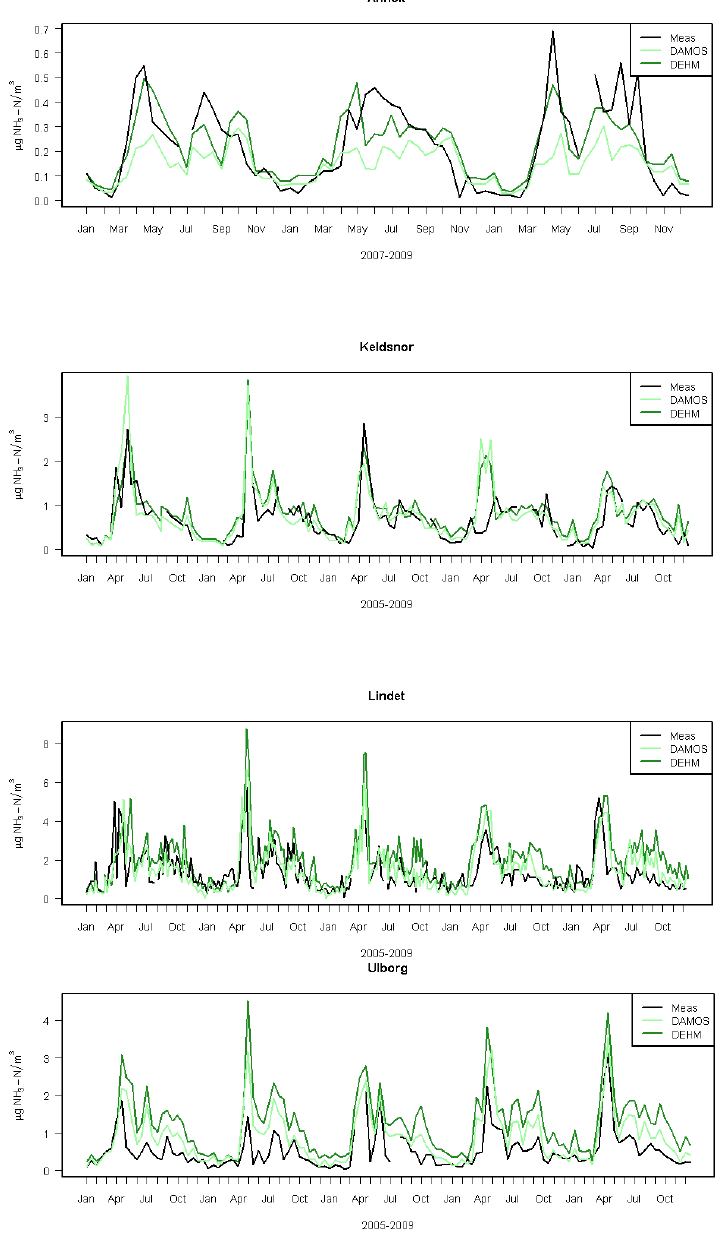
Fig. 6. Time series of measured and modelled NH 3 concentrations at four sites in Denmark covering the period 2005–2009 or 2007–2009. At the Lindet site, mean weekly samples are shown, while at Anholt, Keldsnor and Ulborg 1/2 monthly samples are